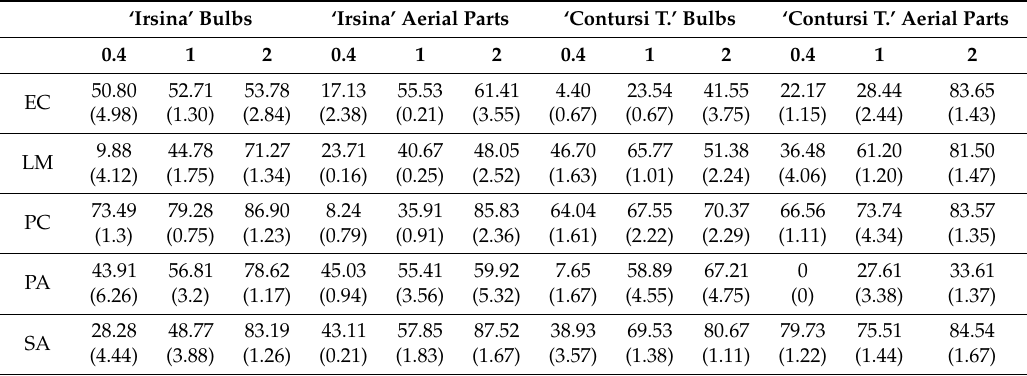
Table 5. Inhibitory activity exhibited by the extracts of bulbs and aerial parts of ‘Irsina’ and ‘Contursi T.’ landraceson24-hpreformedbiofilm. Thedataareexpressedaspercentagerespecttothecontrol(value0). Results are the mean of three experiments ( ± SD). EC: E. coli ; LM: L. monocytogenes ; PC: P. carotovorum ;